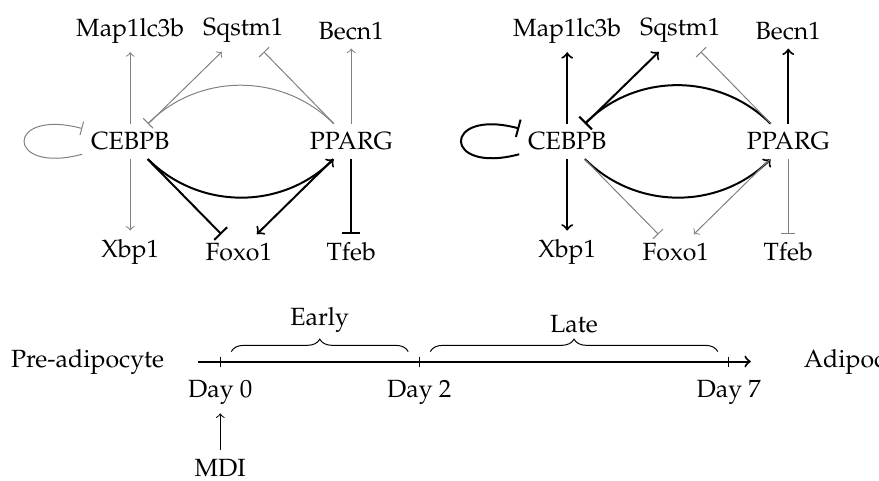
Figure 10. Direct and indirect regulation of autophagy genes by adipogenic transcription factors. A constructed model of the transcriptional activity of two adipogenic factors (CEBPB and PPARG) on their corresponding genes, key autophagy genes ( Map1lc3 , Becn1 and Sqstm1 ) and autophagy transcription factors ( Xbp1 , Foxo1 and Tfeb ). The direction of regulation ( ← , induction; or (cid:96) , repression) is inferred based on the availability of the factor in each stage and the co-expression with the target gene. The change in occupancy and the binding intensity is indicated by the edge type ( − , high; or − ,